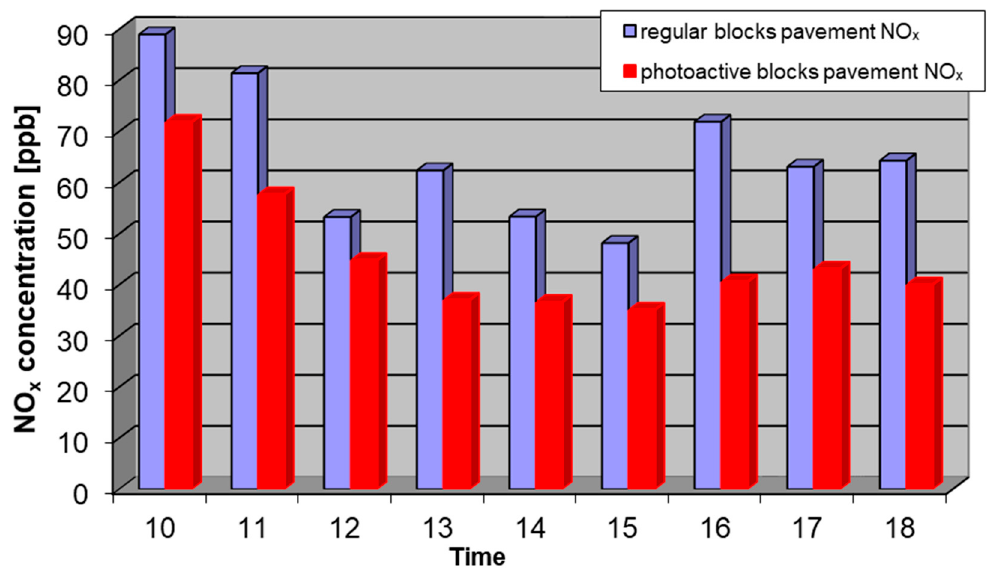
Figure 8. Average concentration of NO x on 12 September 2018 from 10 a.m. to 6 p.m. at the regular pavement (blue) and photocatalytic pavement (red).